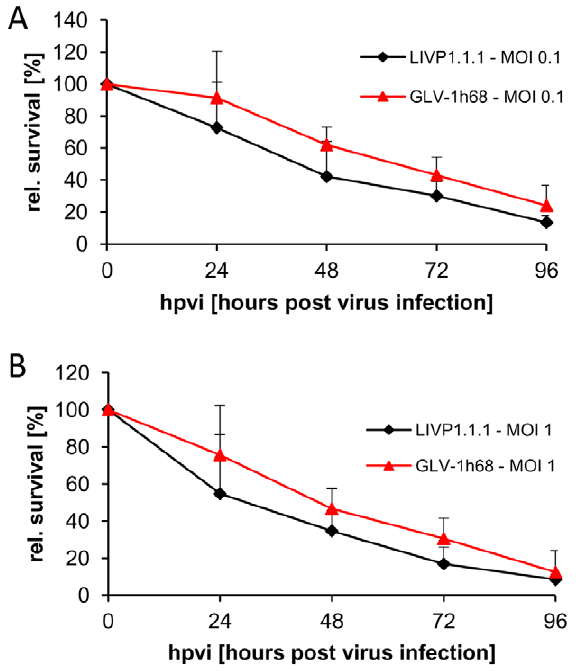
Figure 2. Viability of canine soft tissue sarcoma cells after LIVP1.1.1 or GLV-1h68 infection at MOIs of 0.1 (A) and 1.0 (B), respectively. Viable cells after infection were detected using 3-(4, 5- dimethylthiazol-2-yl)-2,5-diphenyltetrazolium bromide (MTT) (Sigma, Taufkirchen, Germany). Mean values (n=3) and standard deviations are shown as percentages of respective controls. The data represent two independent experiments. There were no significant differences between groups (P . 0.05).